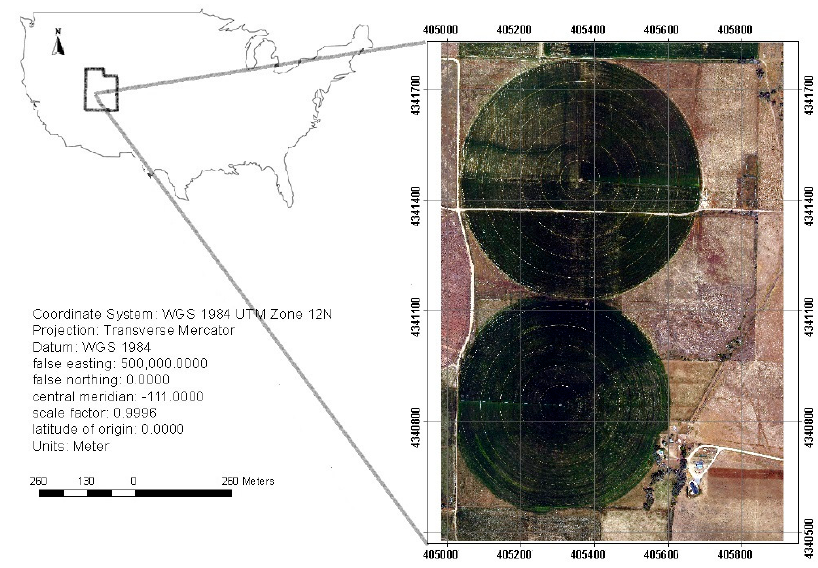
Figure 1. The location of the study area in Utah, United States.